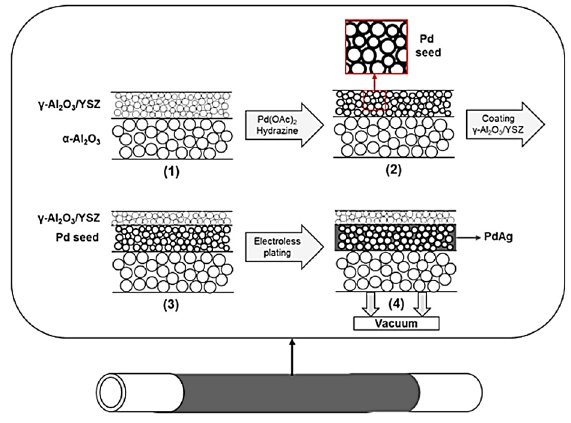
Figure 6. Procedure to prepare pore-filled type membranes [90] with permission from © Elsevier.: (1) Incorporation of a first γ -Al 2 O 3 /YSZ layer; (2) Pd seed on smaller ceramic particles; (3) incorporation of a top additional γ -Al 2 O 3 /YSZ layer and (4) incorporation of a Pd-based layer by vacuum-assisted ELP.